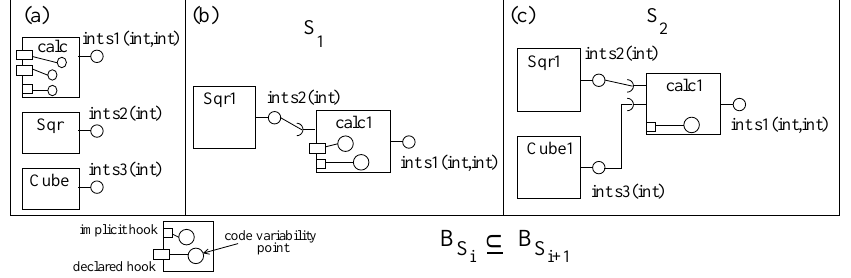
Figure 21. A system of invasive ADL components: ( a ) Components, ( b ) First system, and ( c ) Second